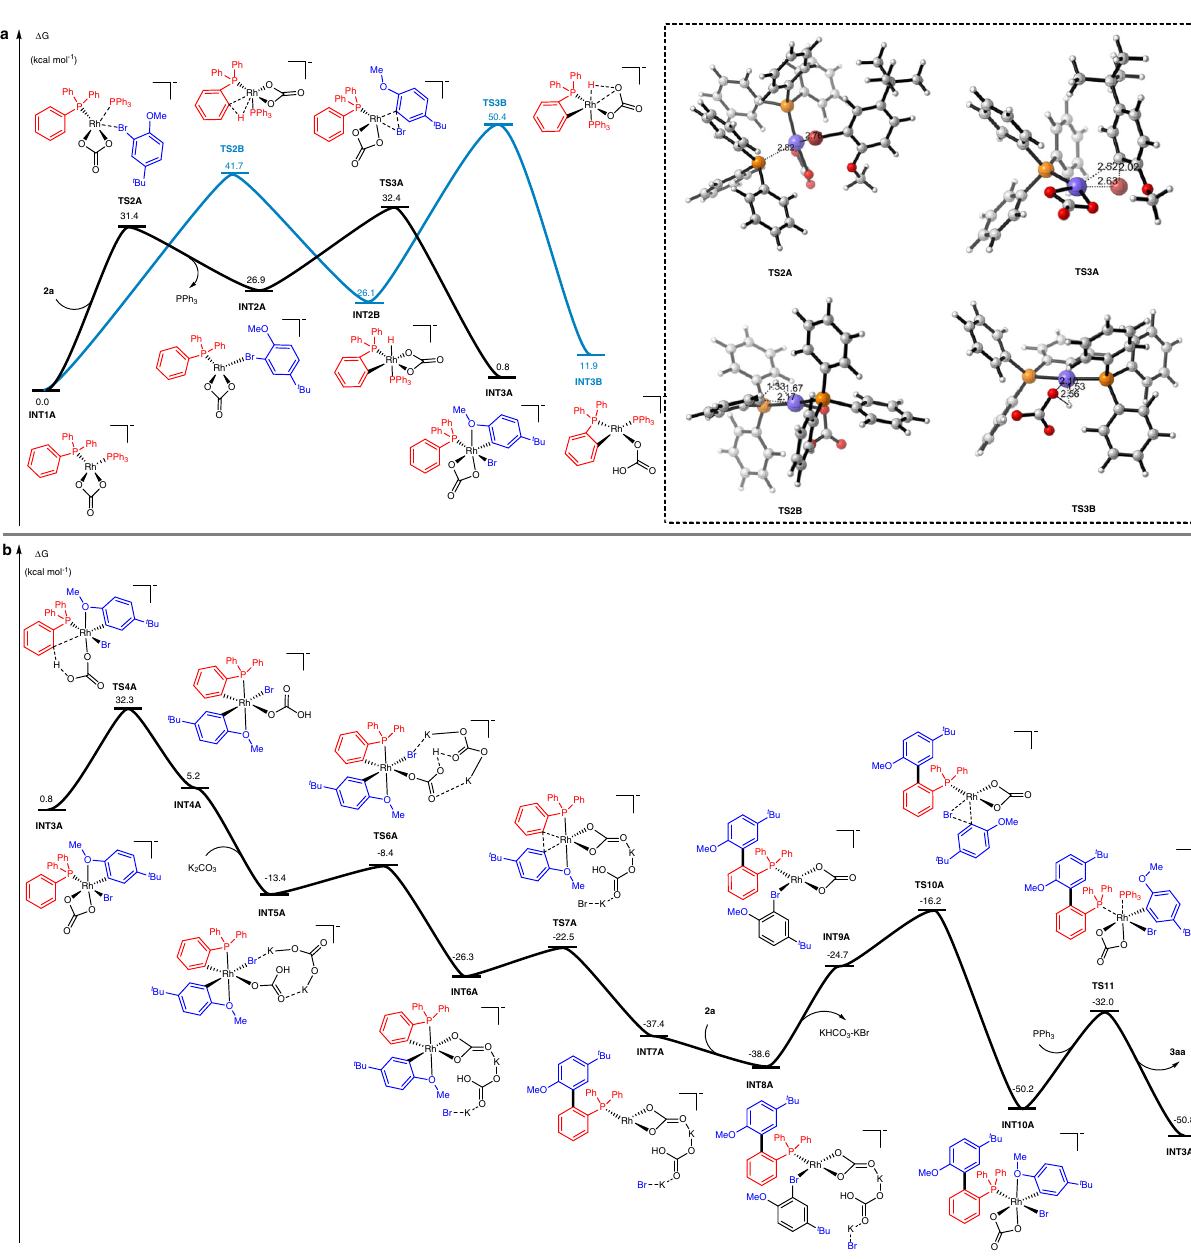
Fig. 7 Plausible reaction mechanism for onefold direct arylation between substrates 1a and 2a. a DFT-computed free energies of the two competitive pathways for C-Br and C-H bond oxidative addition. b The free energy pro fi les for the catalytic cycle of the onefold direct arylation. Energies are in kcal mol − 1 and bond lengths are in Å. The energies were computed at the M06/SDD-6-311 + G(d, p)/SMD (solvent = 1,4-dioxane) level of theory, with geometries optimized at the B3LYP/SDD – 6-31 G(d)